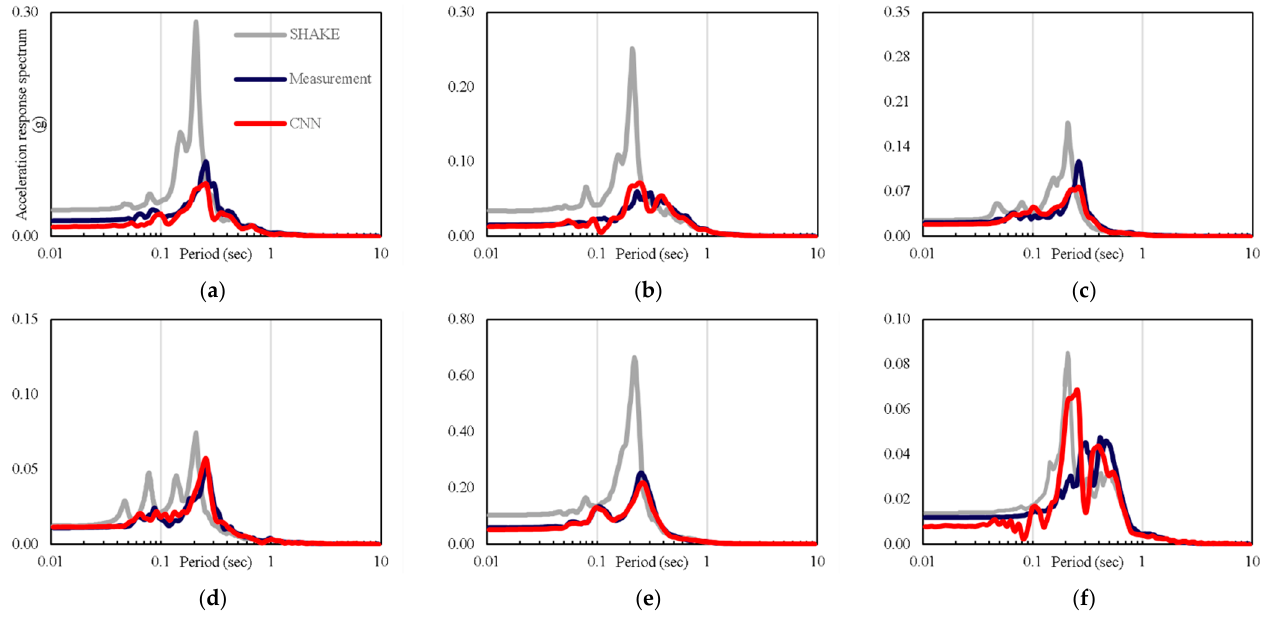
Figure 10. The six samples of acceleration response spectra measurements and predictions at site FKSH17. ( a ) FKSH171201011428.EW. ( b ) FKSH171201011428.NS. ( c ) FKSH171204131910.EW. ( d ) FKSH171206180532.NS. ( e ) FKSH171305181448.EW. ( f ) FKSH171309040919.NS2.